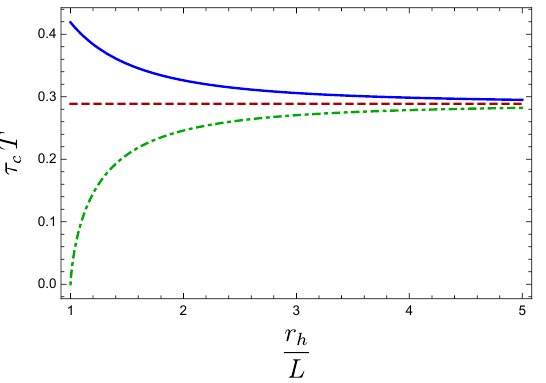
Figure 19 . Critical time as a function of the horizon radius for d = 3 for the various geometries | spherical k = 1 (blue, solid), planar k = 0 (red, dashed) and large hyperbolic k = (cid:0) 1, r h > L (green, dot-dashed).